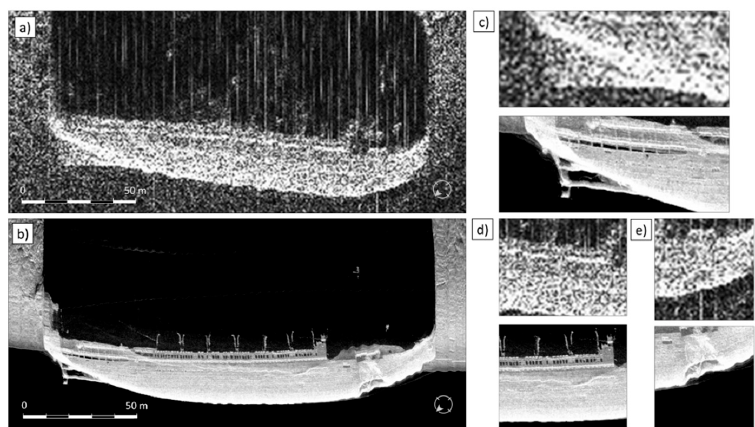
Figure 8. Side-scan sonar images of the shipwreck of the General von Steuben . ( a ) sonar imagery recorded with hull-mounted, 100 kHz side-scan sonar; ( b ) sonar imagery recorded with towed, 500 kHz side-scan sonar; ( c ) displaying shafts and propellers; ( d ) displaying front part of the superstructure and davits; and ( e ) displaying torpedo hole in the shipwreck hull.